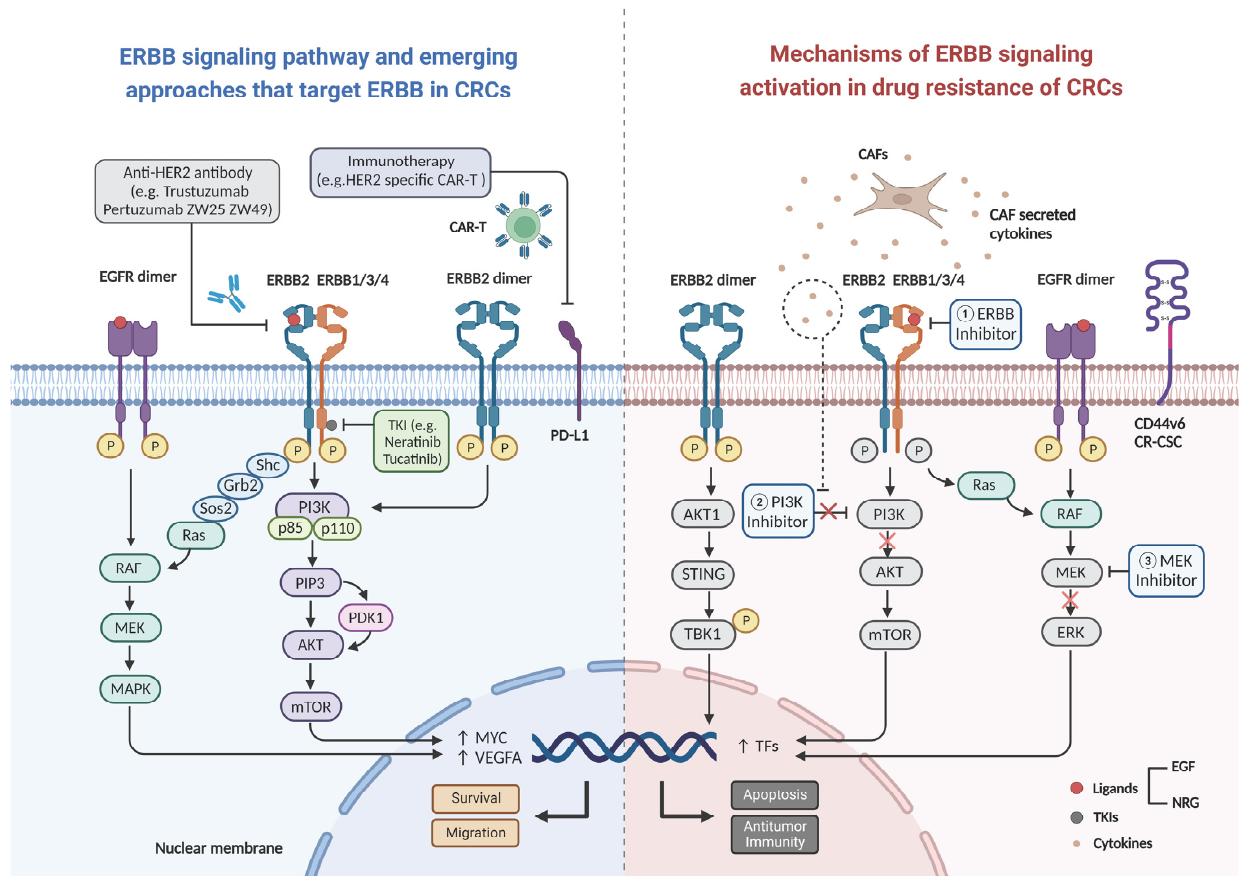
Figure 2. Schematic diagram of ligand binding activation of the ERBB2 signaling pathway leading to drug resistance. Uncontrolled formation of homo- or heterodimers, upon ERBB2 activation under physiological conditions, leads to the activation of two key downstream signaling pathways (the MAPK and PI3K-Akt pathways) and initiation of a series of cellular processes such as survival and migration. Mechanism of inhibition of the signaling pathway by various novel ERBB2 drugs ( left ), and the mechanisms of resistance to anti-EGFR therapy and immunotherapy due to activating of ERBB signaling pathway ( right ). Abbreviations: CAR-T: chimeric antigen receptor T-cell, CAFs: cancer associated fibroblasts, PD-L1: programmed cell death ligand 1, EGF: epidermal growth factor, NRG : neuregulin, CR-CSC: colorectal cancer stem cell, VEGFA: vascular endothelial growth factor A, TFs: tumor factors.